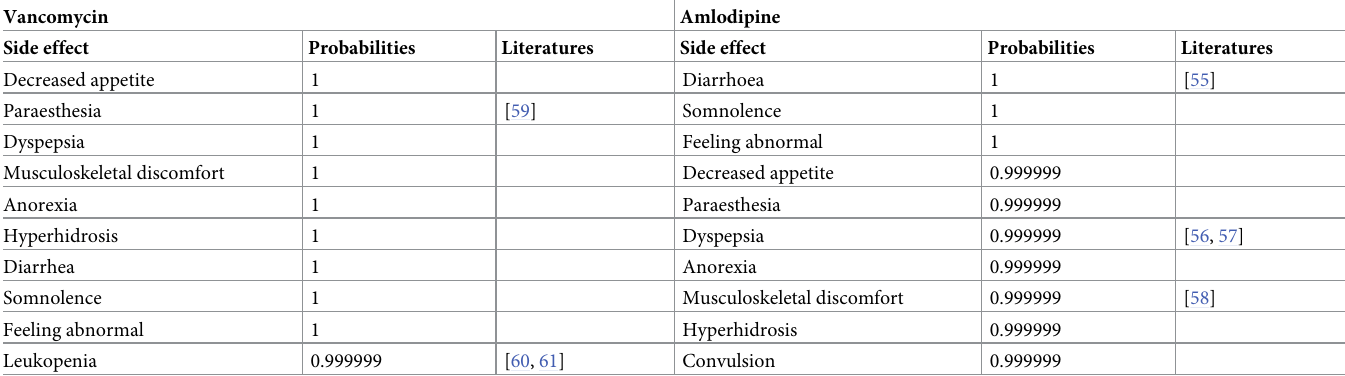
Table 9. New predictions not seen in the dataset SIDER.